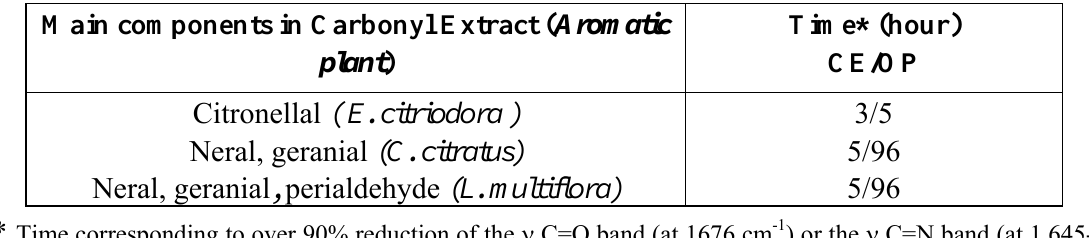
Table 3. OP volatility analysis by FT-IR